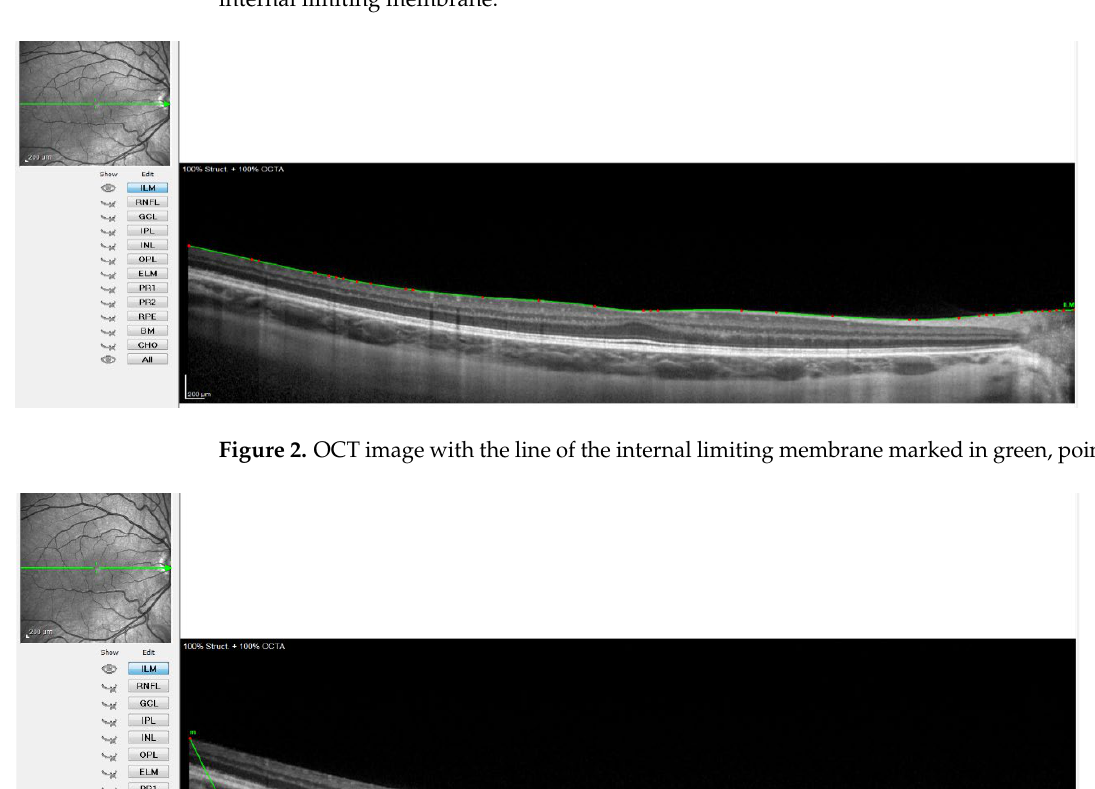
Figure 1. OCT image with lines in red corresponding to the retinal pigment epithelium and the internal limiting membrane.